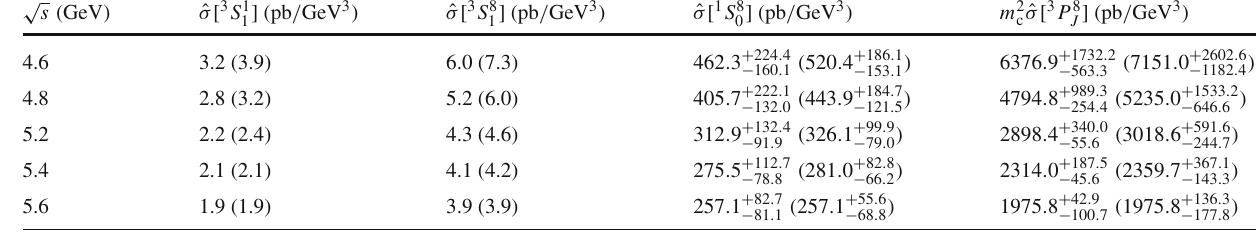
Table 2 The SDCs of different channels for J /ψ Fock states in of m c and (cid:2) v 2 (cid:3) . The strong-coupling constant α s is running with the center-of-mass energy region of 4 . 6 − 5 . 6 GeV are listed in this the renormalization scale μ . In each cell, the number outside the ] , which is defined in Eq. (2). bracket is evolved with μ = 2 m c and μ = table and denoted by ˆ σ [ 2 s + 1 L 1 , 8 J The uncertainties of the color-octet SDCs are combined from that